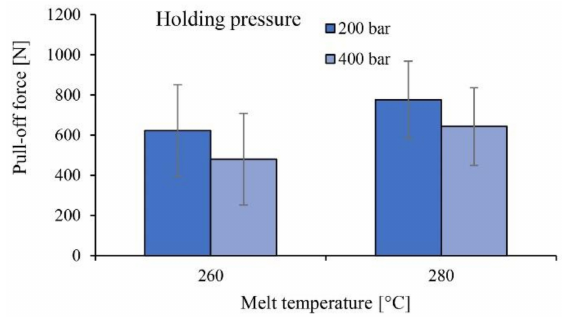
Figure 4. The pull-off force with the low and the high melt temperature.